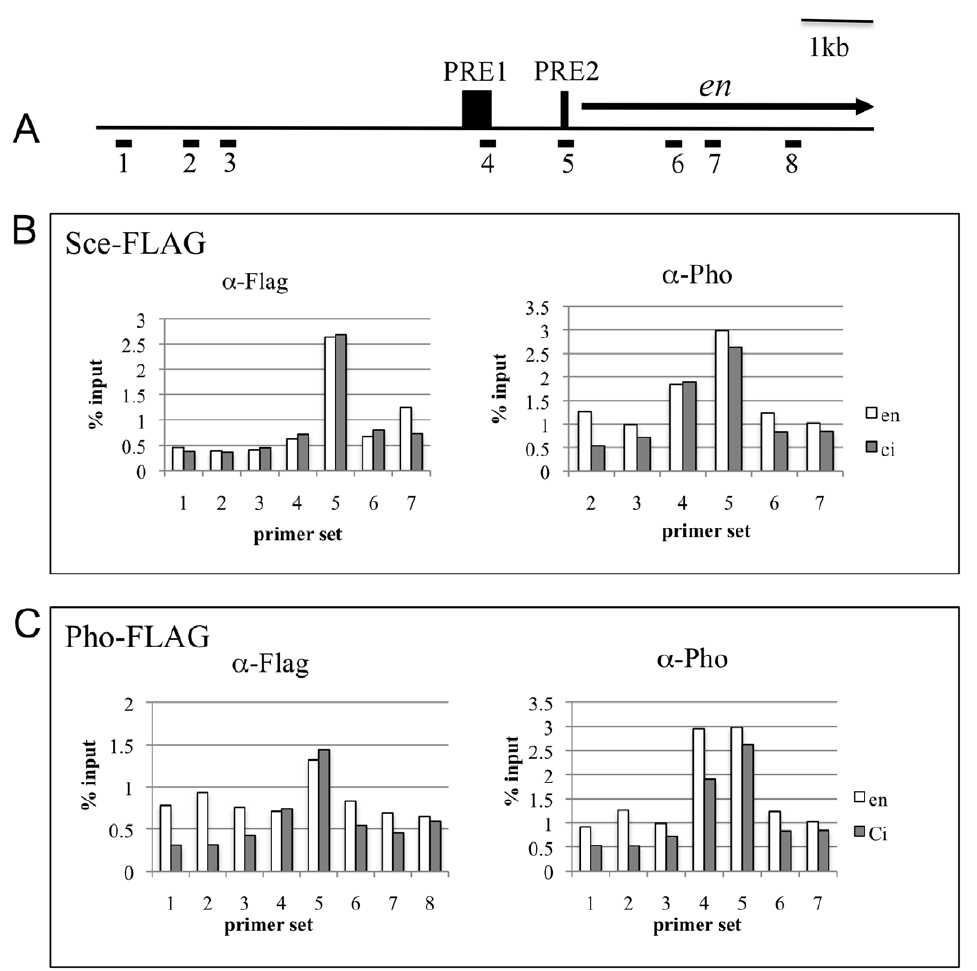
Figure 4. Pho-FLAG and Sce-FLAG binding peaks at PRE2. (A) A map of the en gene showing the location of the PREs and the probes used for the qPCR ( # 1–8). (B,C) Results of X-ChIP experiment with Sce-FLAG (B) and Pho-FLAG (C) driven by en -Gal4 (open bars) or ci -Gal4 (closed bars). Pho binding was also done on all chromatin preparations. The results of a representative experiment are shown. These experiments were done with a different batch of FLAG antibody and different ChIP reagents than those done in Fig. 5. Further, 20 larvae were used for each sample instead of 10. Under these conditions, we did not see a difference in the level of binding to the PREs between the ‘‘ON’’ and the ‘‘OFF’’ states; however, the qualitative result, PcG proteins binding to PRE2 in both the ‘‘ON’’ and ‘‘OFF’’ states was the same in these experiments and those in Fig. 5.